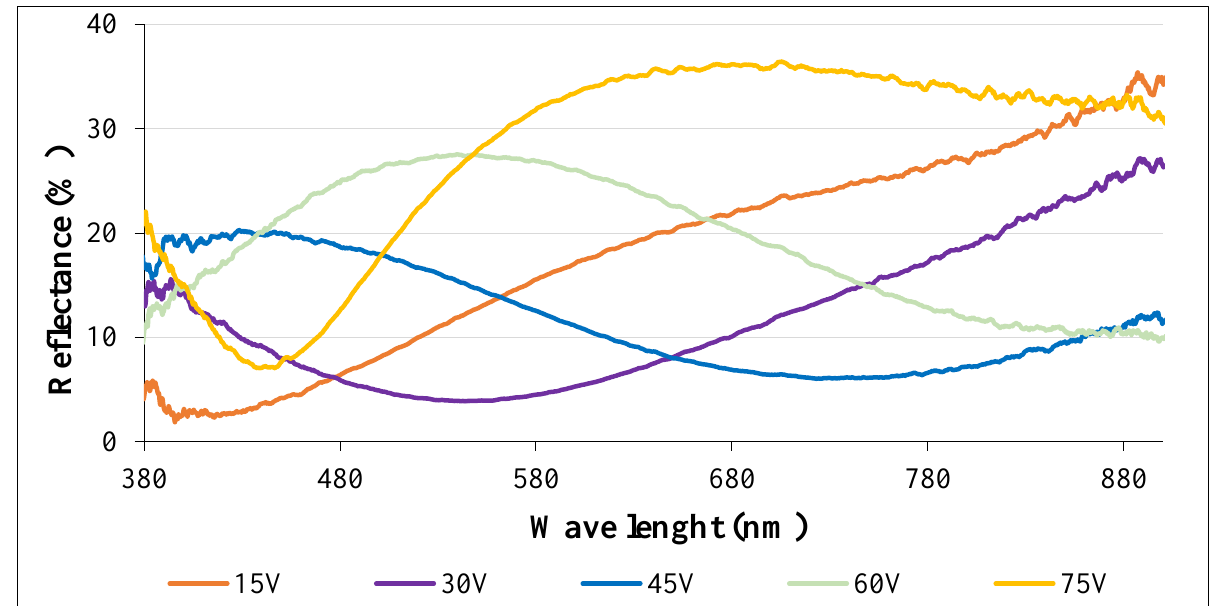
Figure 2. Reflectance specters for samples anodized at different voltages.